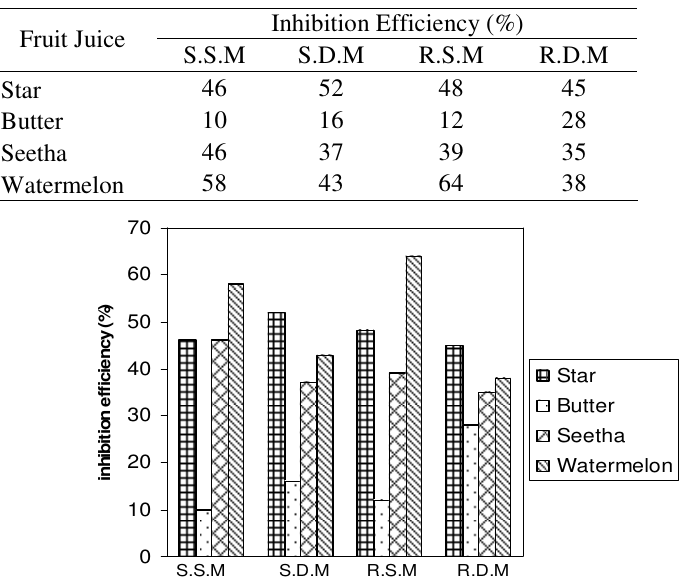
Figure 3. Inhibition of calcium carbonate mineralization by fruit